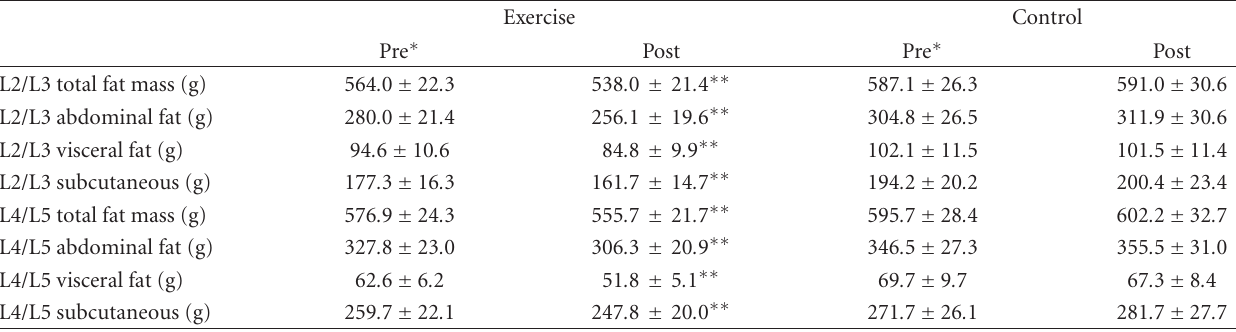
Table 3: Changes in computed tomography scan variables for the high-intensity intermittent exercise and no exercise control groups ( N = 38; mean and standard error).